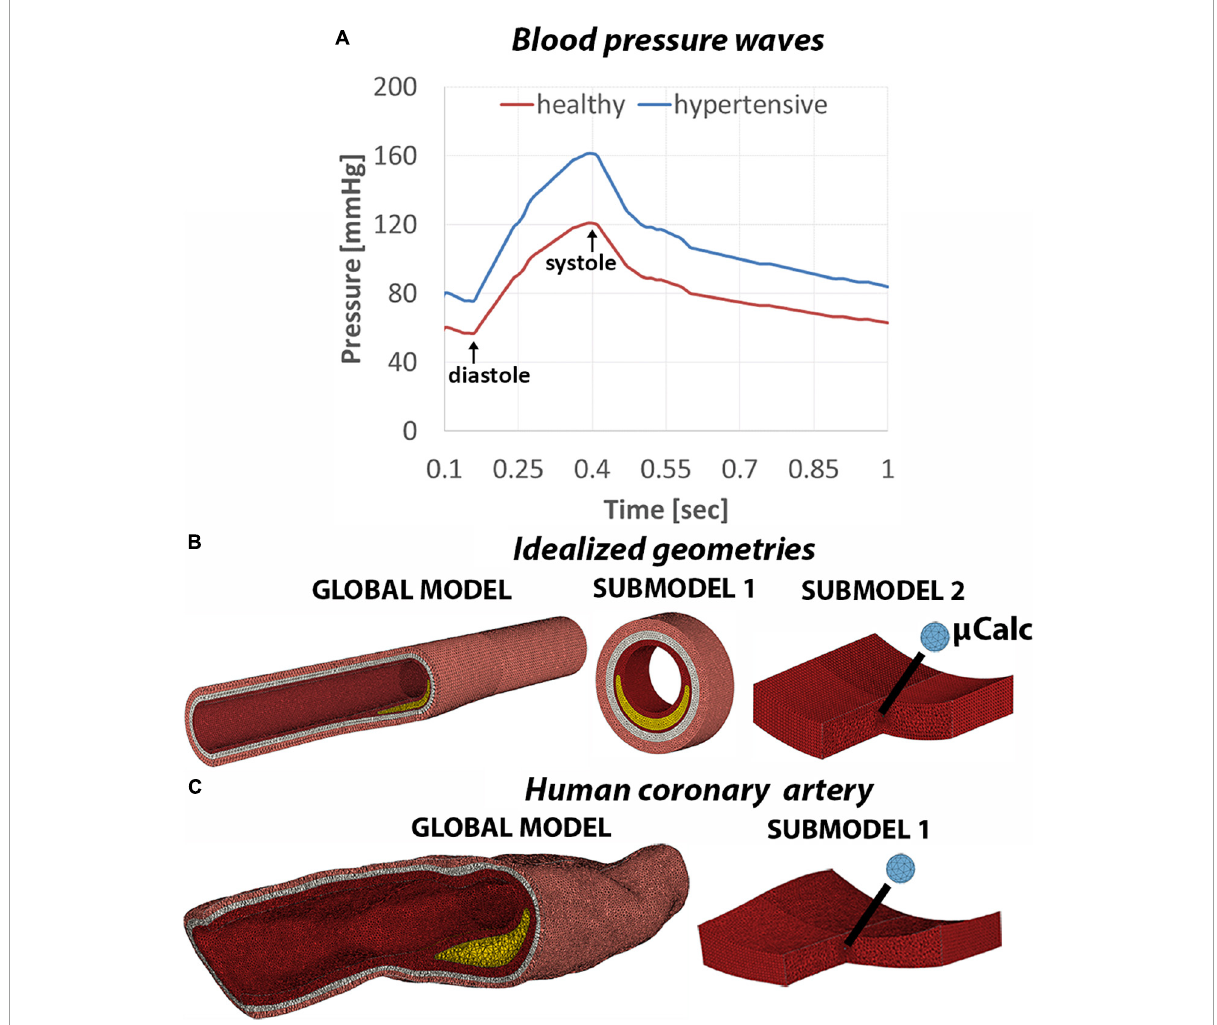
FIGURE2 (A) Normal and hypertensive pressure waves applied to the lumen of the artery to replicate blood flow on 1-second time span. Mesh view of the global model and subsequent submodels of the idealized geometries (B) and human coronary sample (C)